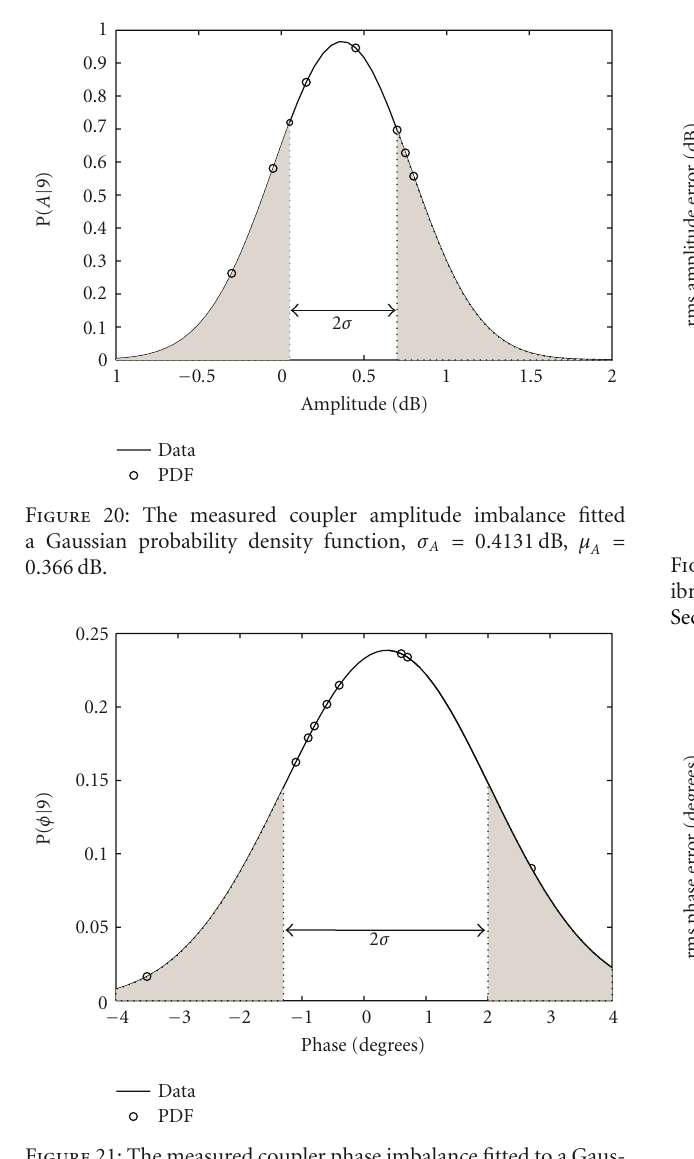
Figure 21: The measured coupler phase imbalance fitted to a Gaus- sian probability density function σ φ = 1.672 ◦ , μ φ = 0.371 ◦ .